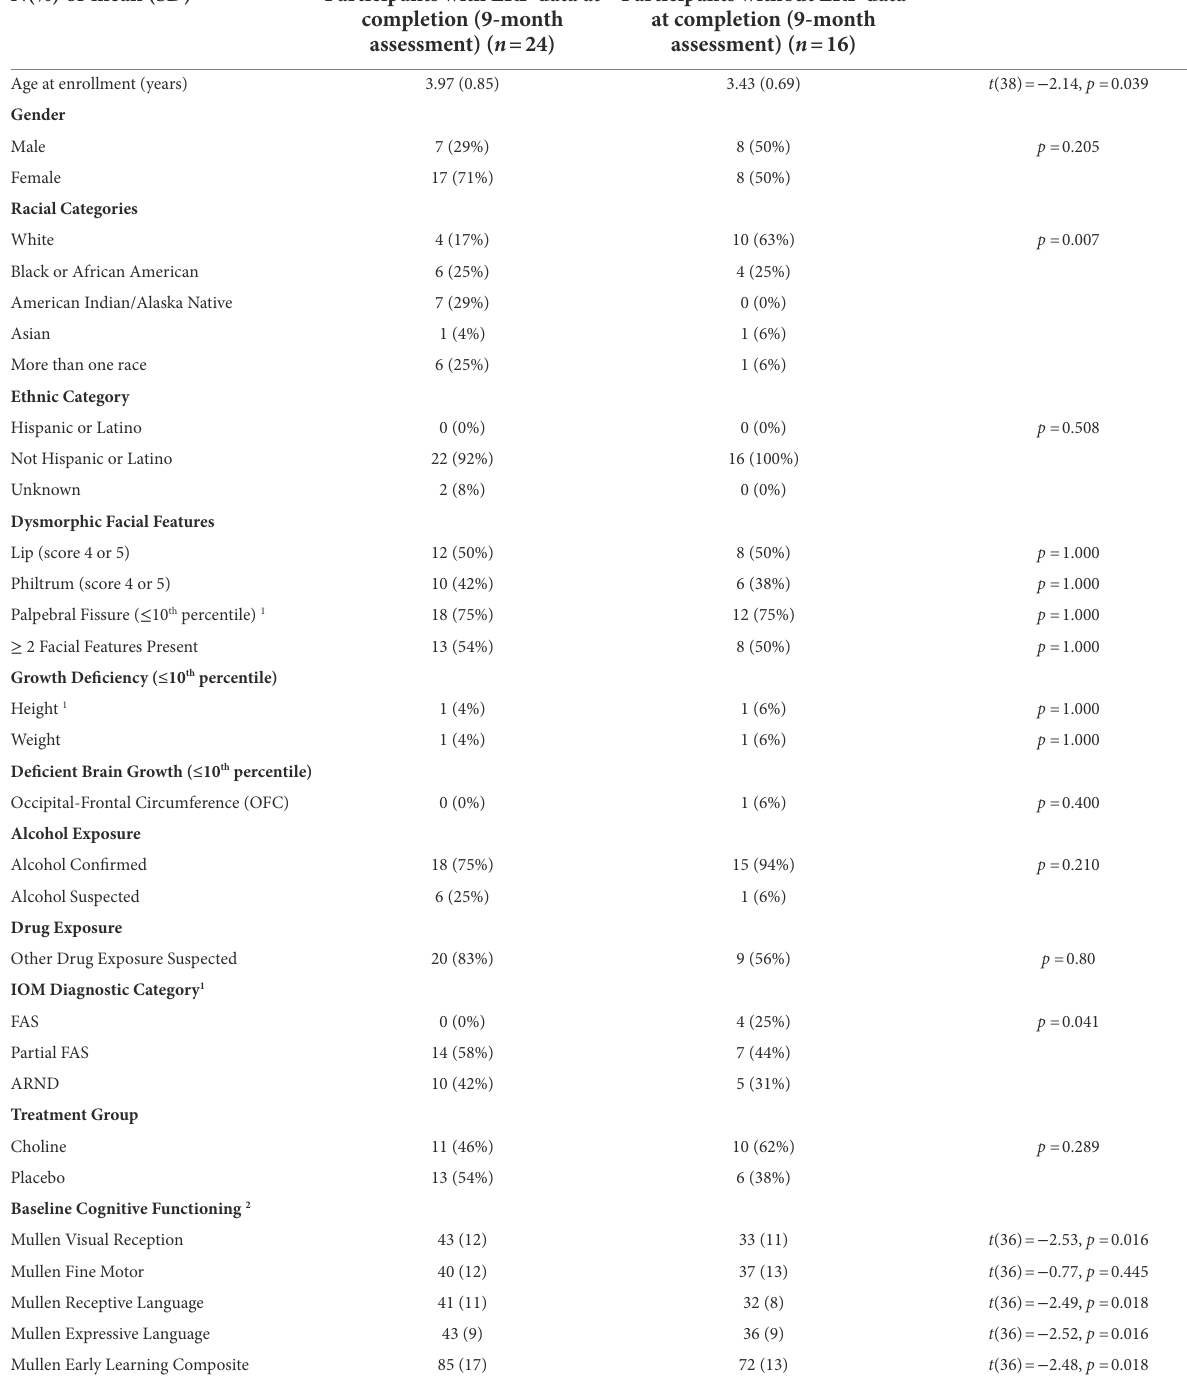
TABLE 1 Characteristics at study enrollment of the subsample with usable ERP